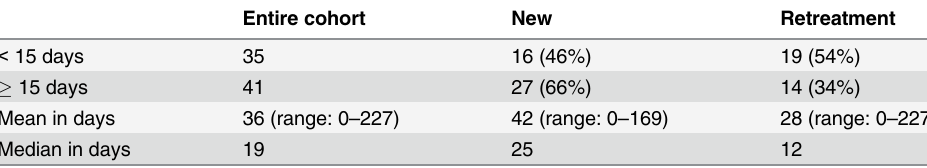
Table 4. Duration for